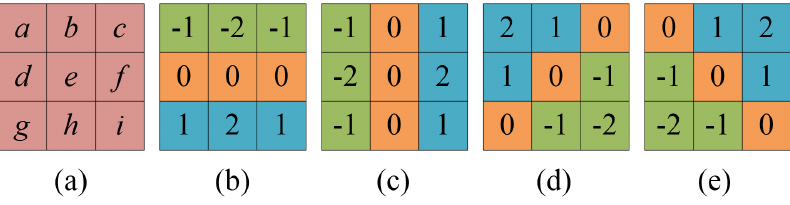
Figure 7. Sobel filters for different directions. ( a ) Example of a 3 × 3 square pixel block to be filtered by Sobel filters. ( b ) Sobel filter for horizontal direction. ( c ) Sobel filter for vertical direction. ( d , e ) Sobel filters for 45 ◦ and 135 ◦ ,